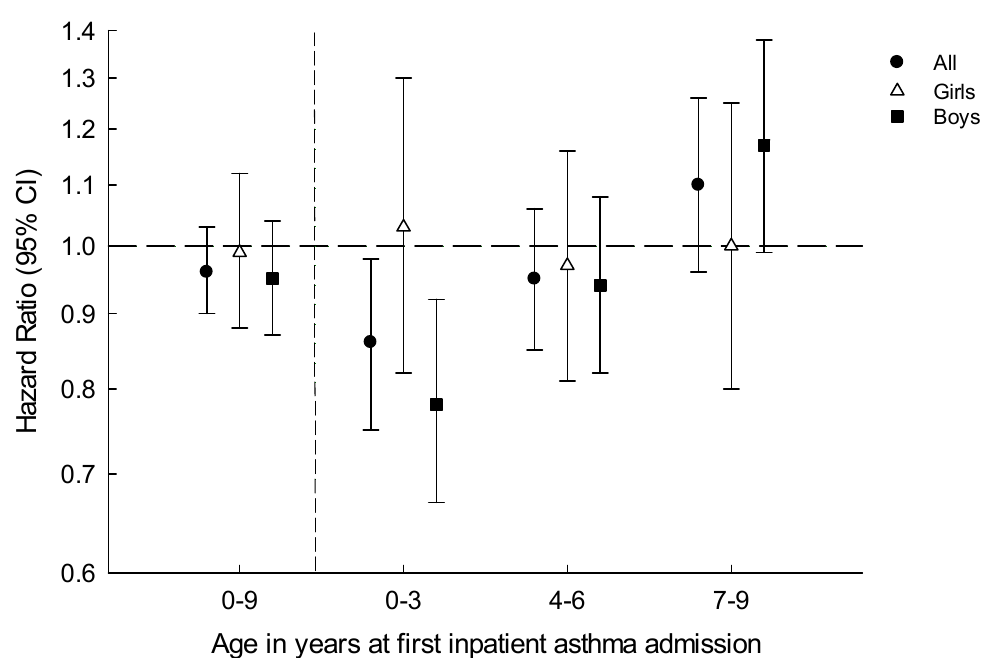
Figure 3. Hazard ratio of childhood asthma among those prenatally exposed to the margarine fortification with vitamin D policy, compared to those unexposed.